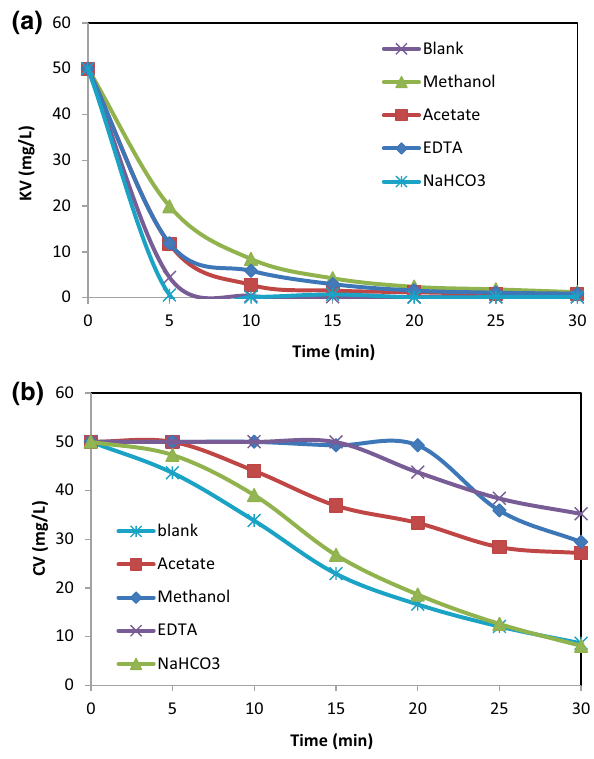
Fig. 5 Effects of free radical scavengers on peroxone a and e-perox- one/H 2 O 2 b efficiency condition: reactor volume 500 cc and 70 rpm, applied current 0.1 A, NaCl 100 mg/L, pH 9, ozone 2 mg/L. min and H 2 O 2 15 mmol/L Table 1 Reaction constant rate of hydroxyl radical with some organic and inorganic